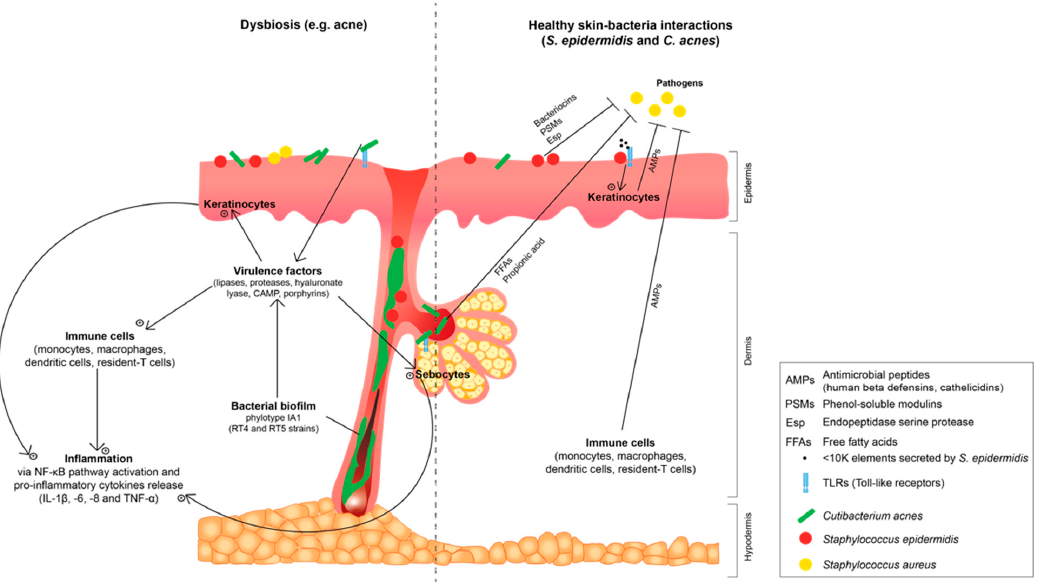
Figure 2. Skin–bacteria interactions in dysbiosis (e.g., acne) and healthy skin: focus on Staphylococcus epidermidis and Cutibacterium acnes , adapted from Claudel et al. (2019) and O’Neill et al. (2018)